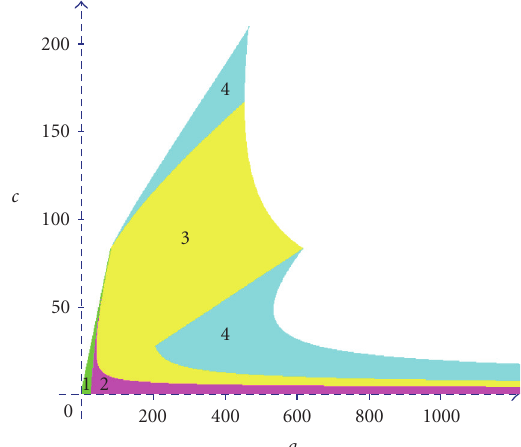
Figure 5.6 . Regions of su ffi cient stability condition and necessary and su ffi cient stability condition for (5.2): p = 0, h = 0 . 024, Δ = 0 .